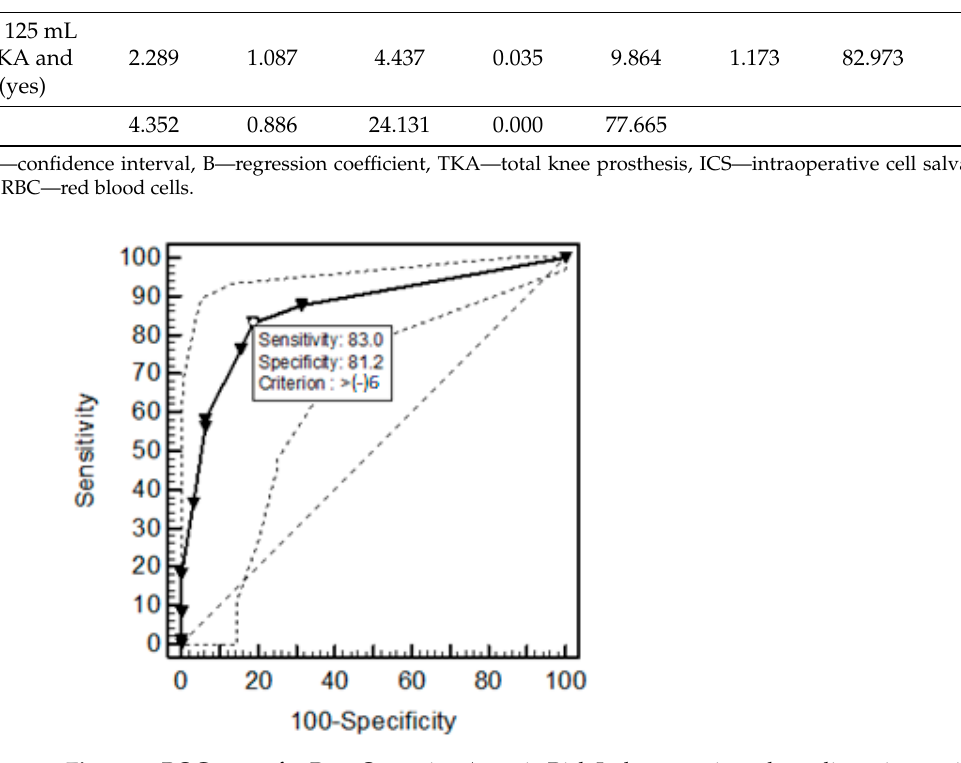
Figure 1. ROC curve for Post-Operative Anemia Risk Index score in orthopedic patients with hip or knee arthroplasty.